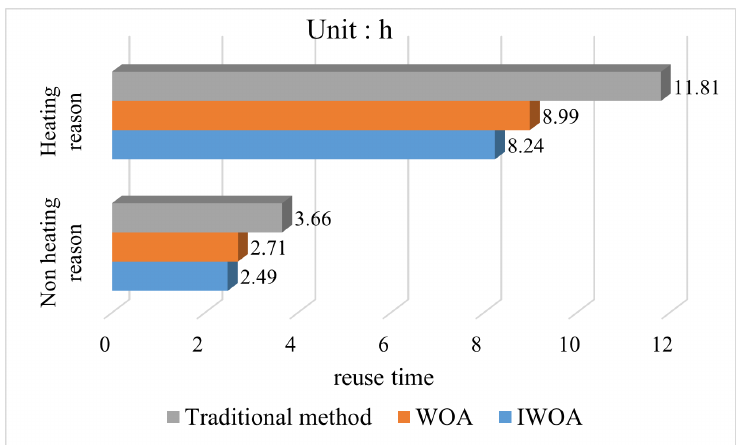
Figure 17. Comparison chart of mine water reuse